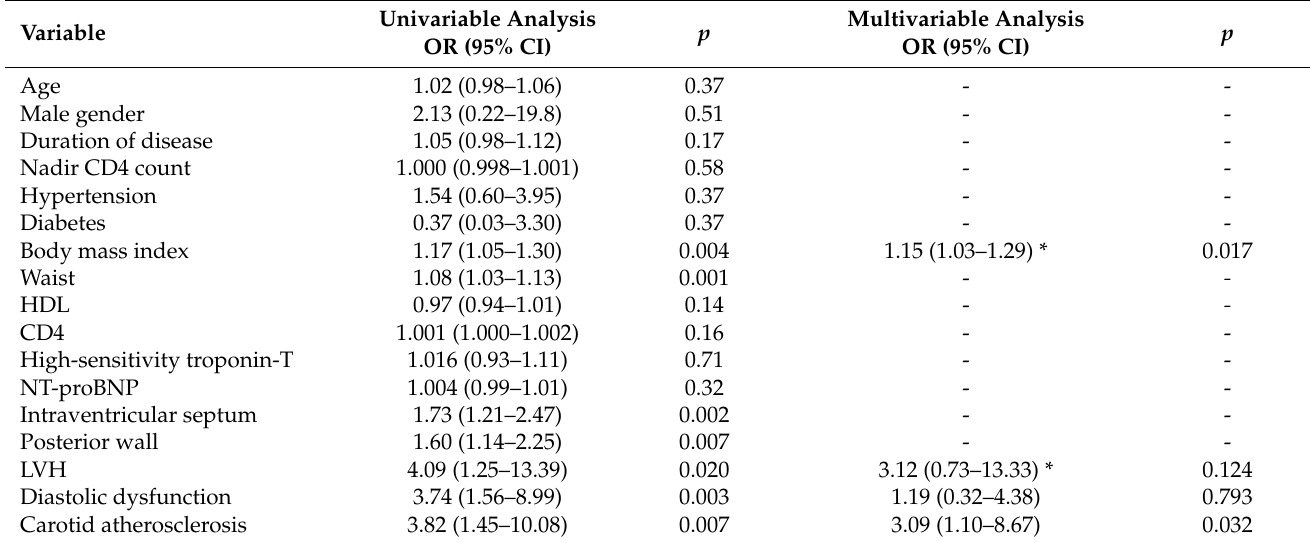
Table 4. Univariable and multivariable logistic regression analysis for the presence of left ventricular systolic dysfunction among